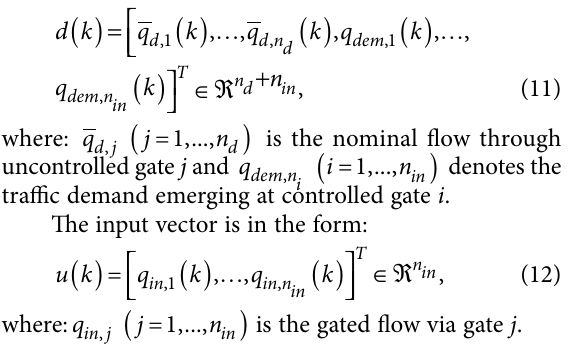
Boundary of the protected network